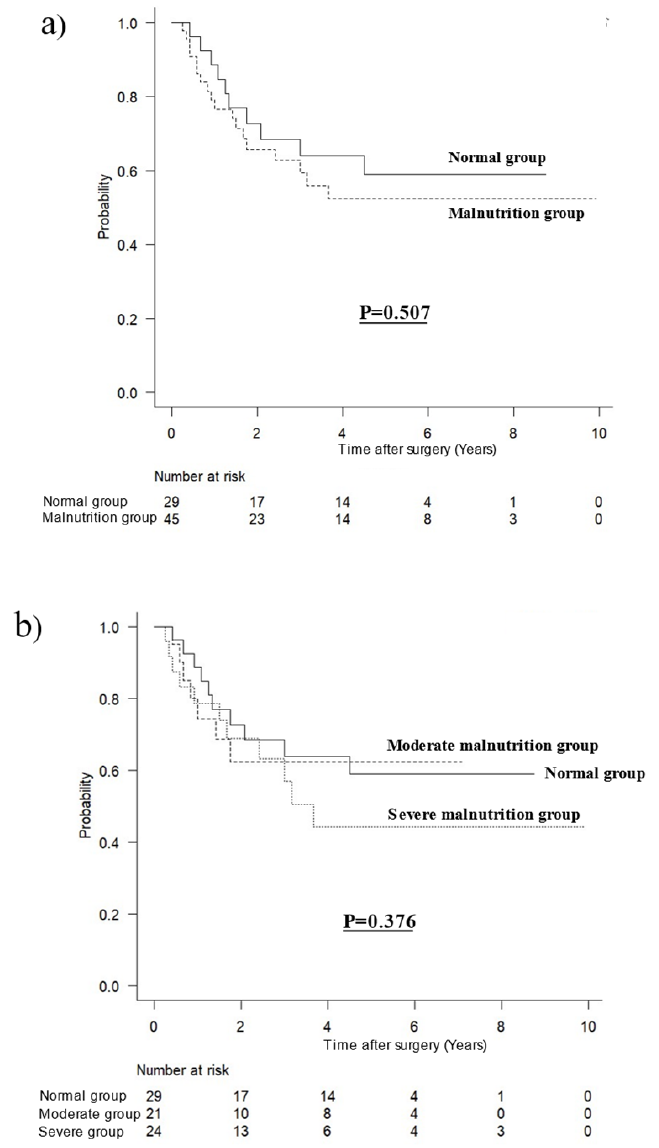
Figure 2. Survival curves for overall survival in patients with inflammation. ( a ) According to malnutrition, ( b ) according to severity of malnutrition.